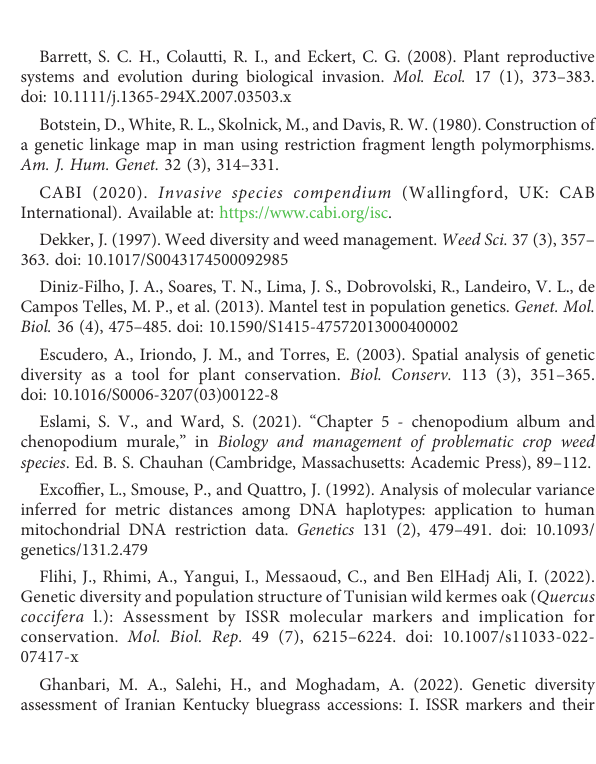
SUPPLEMENTARY FIGURE 1 Maps showing the sample collection locations for ecotypes of A. retro fl exus ( A , top map with pink pins) and C. album ( B , bottom map with yellow pins). The samples were also described in Hamidzadeh Moghadam et al., 2021). The black bar in the Caspian Sea is showing 200 km. For A. retro fl exus , the three collections from Spain all fall under the same pin location on this scale. Likewise, for C. album , the two Spanish and the two French ecotypes are represented by the same pins. SUPPLEMENTARY FIGURE 2 ISSR patterns generated by UBC810 primer on 16 A. retro fl exus (A) and 17 C . album (B) populations DNA. The ladder is a 50 bp DNA Ladder (SinaClon). Lanes designate based